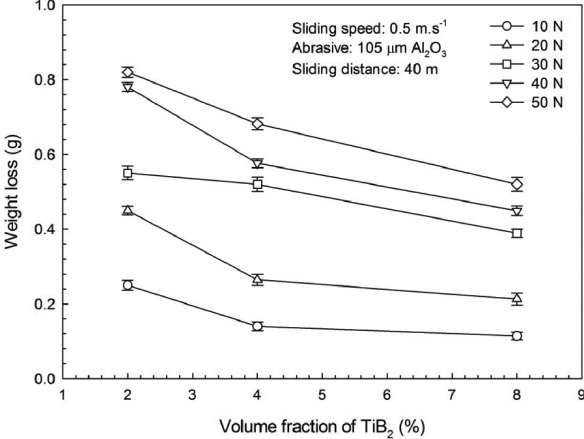
Fig. 7: The variation of weight loss of the composites as a function of TiB 2 content